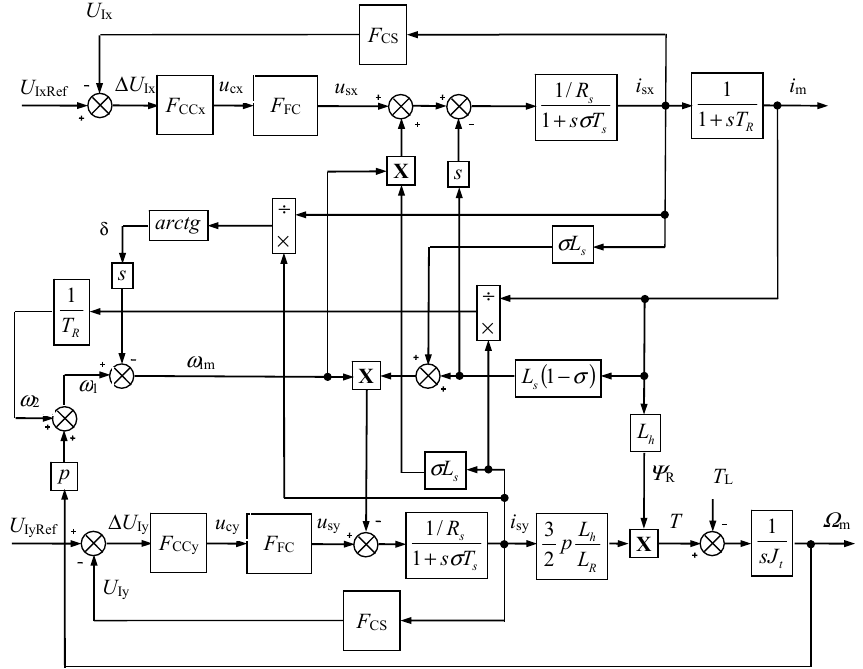
Figure 2. Stator current control scheme of vector-controlled induction motor without decoupling block.